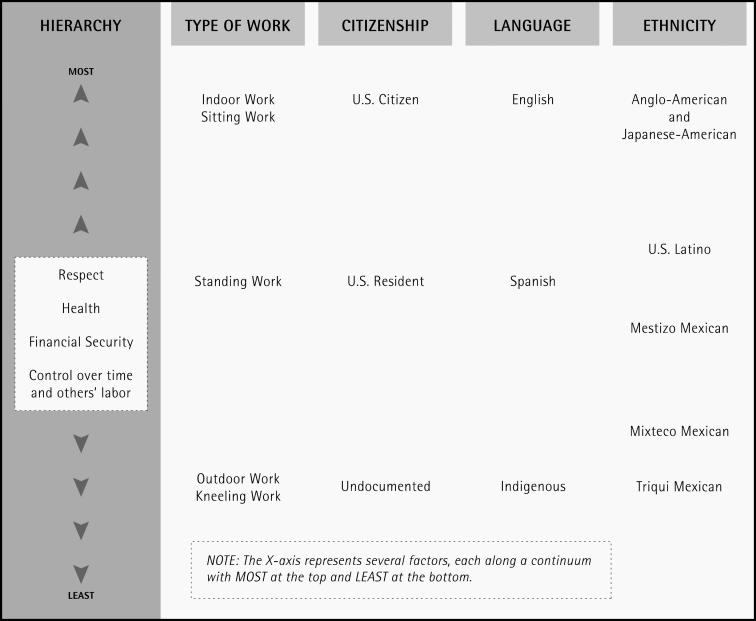
Conceptual Diagram of Hierarchies on the Farm